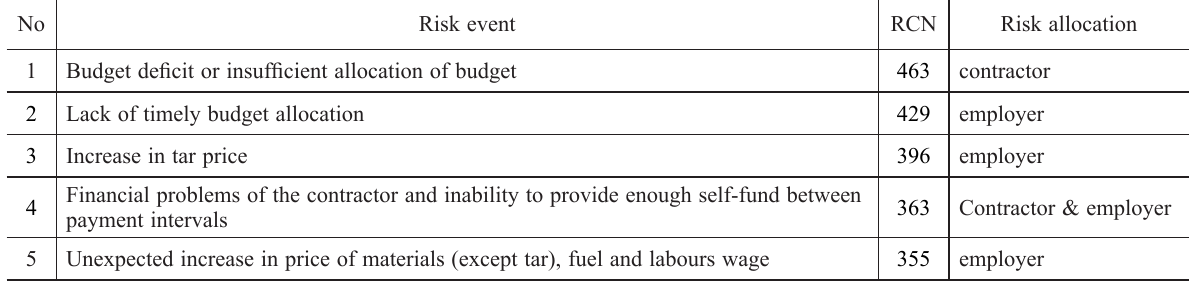
Table 3. Top five risk events in the highway construction project in the descending order of RCN